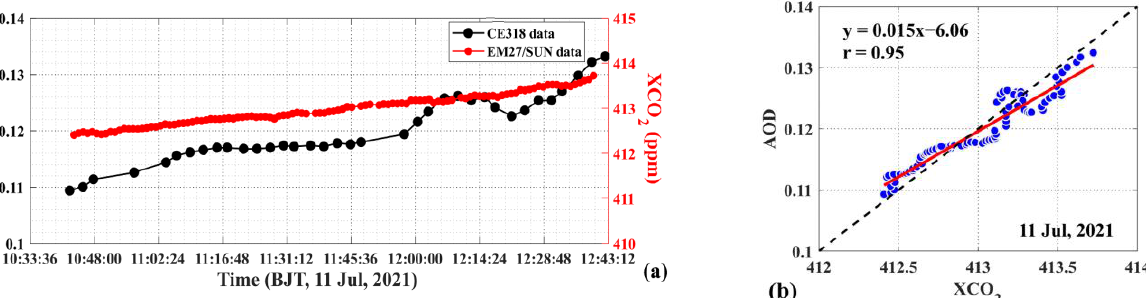
Figure 12. Measurement results of XCO 2 and AOD at the CRCS ground station on 11 July 2021 ( a ). The red dots represent the XCO 2 results measured by EM27/SUN, and the black scatter points represent the AOD results measured by CE318. ( b ) The correlation analysis result of XCO 2 and AOD.